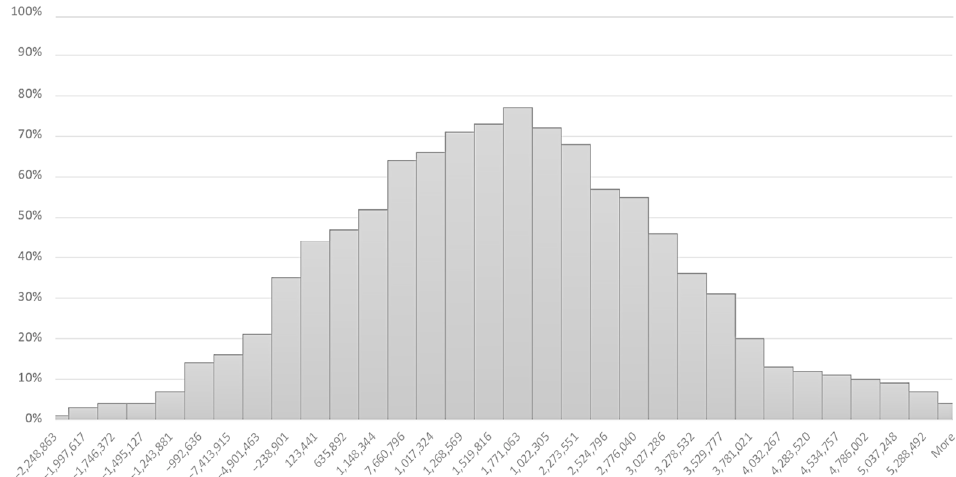
Figure 4. Histogram of profit (EUR) at Vojany black coal power plant. Source: Own processing.